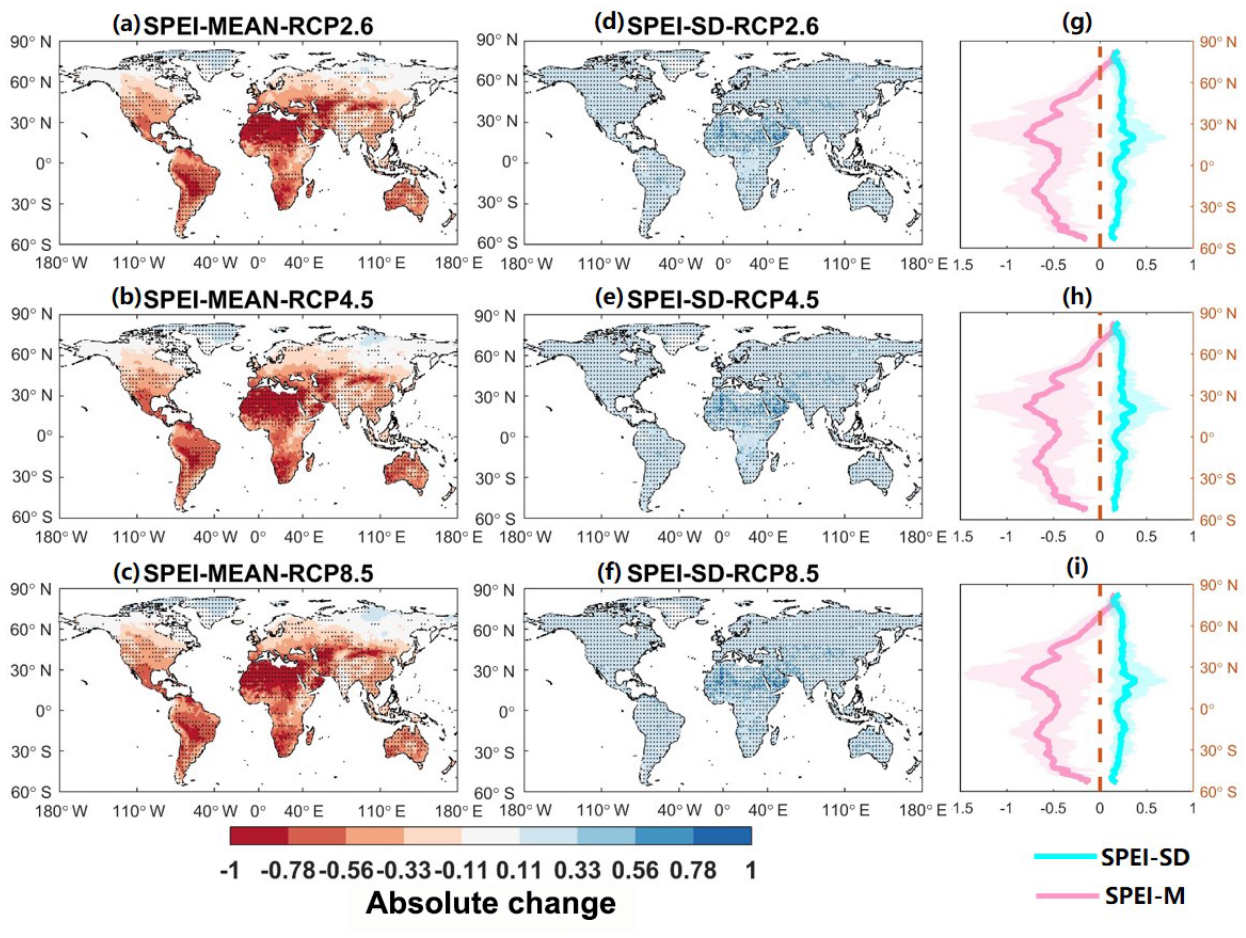
Figure 2. Projected changes in the mean and standard deviation of the SPEI under the 1.5 ◦ C warming